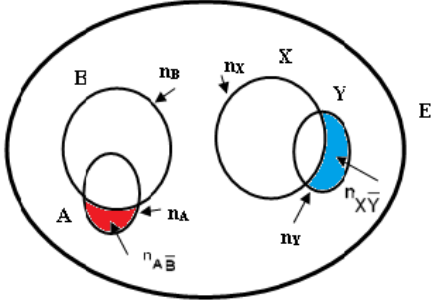
Figure 1 : The model represents a statistical implication rule a →